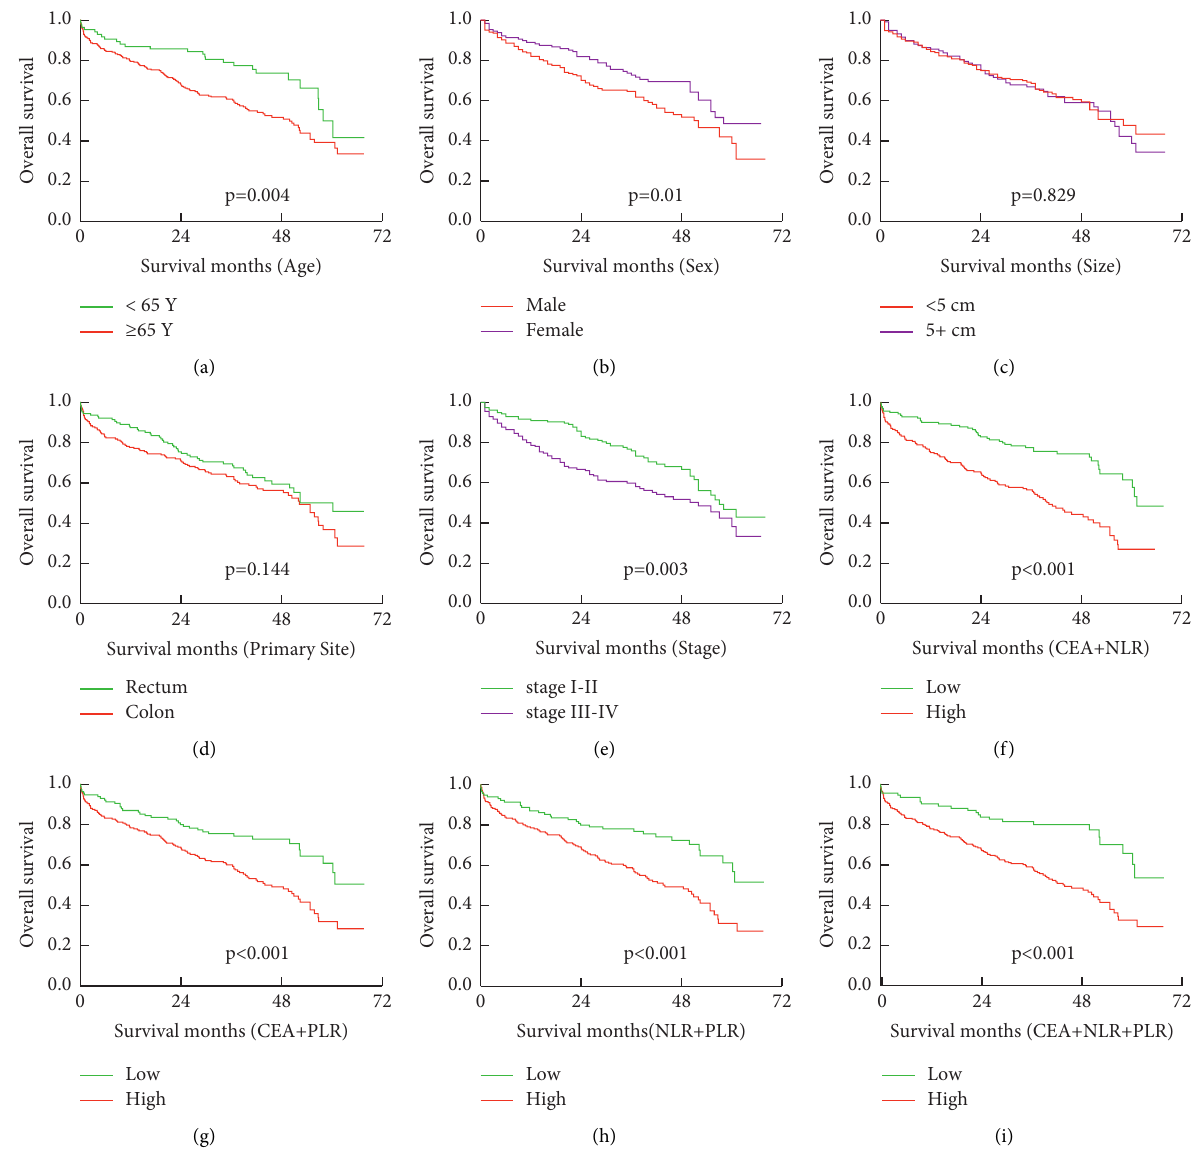
Figure 1: Kaplan–Meier estimates of overall survival (OS) according to the main clinical variables status:(a) according to age status ( P � 0 . 004), (b) according to sex status ( P � 0 . 01), (c) according to tumor size status ( P � 0 . 829), (d) according to primary site status ( P � 0 . 144), (e) according to stage status ( P � 0 . 0036), (f) according to CEA +NLR ( P < 0 . 001), (g) according to CEA+ PLR ( P < 0 . 001), (h) according to NLR+PLR ( P < 0 . 001), and (i) according to CEA +NLR+PLR ( P < 0 .